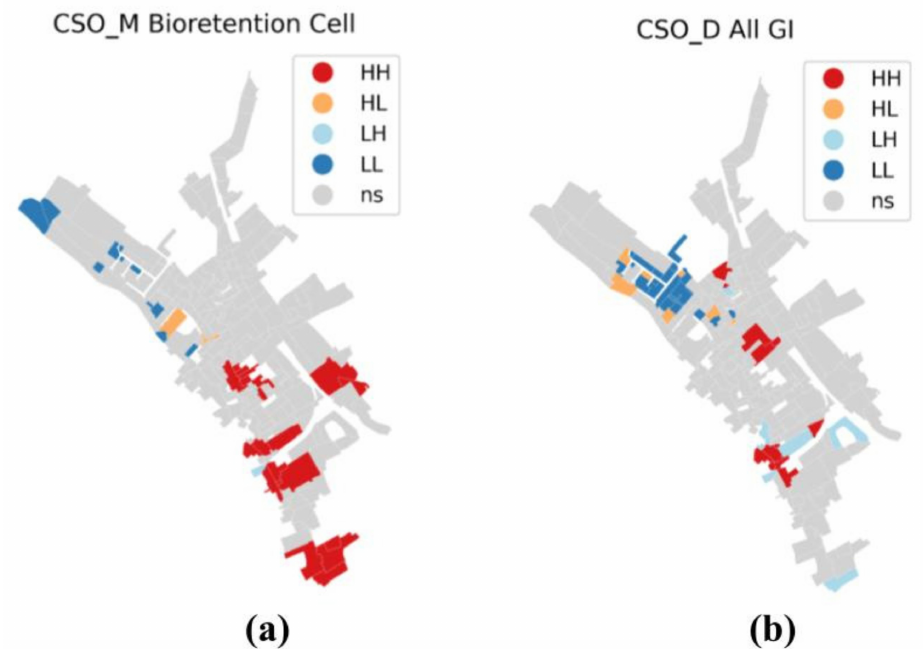
Figure 9. LISA cluster map for GI impacts in resilience enhancement. HH—High-high cluster. HL—High- low cluster. LH- Low-high cluster. LL—low-low cluster. ns: non-significant. Level system failure measurement: CSO. ( a ) LISA cluster map for the bioretention cell using CSO magnitude (CSO_M) as resilience indicator. ( b ) LISA cluster map for “all GI” using CSO duration (CSO_D) as resilience